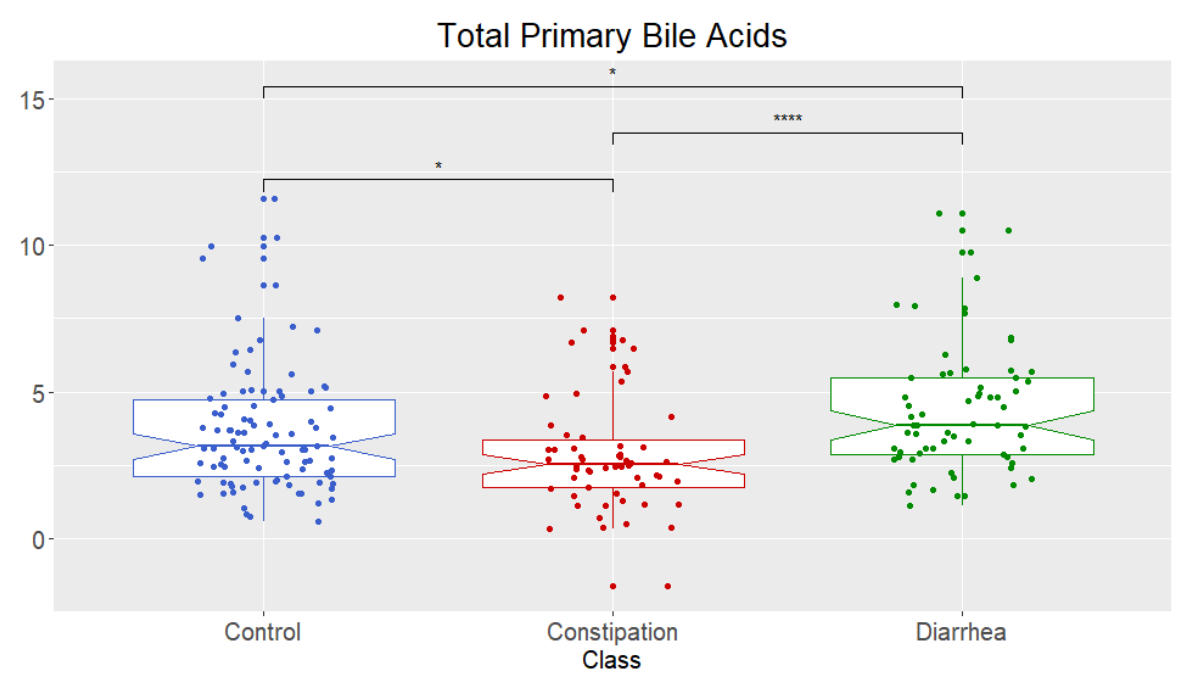
Figure 5. Total concentrations of fecal primary bile acids (sum of chenodeoxycholic acid (CDCA) and cholic acid (CA)) for healthy control and combined groups. Data presented as logged values of µg/mg of dried weight. Healthy control, constipation (FC + IBS-C) phenotype, diarrhea (FD + IBS-D) phenotype. Boxplots show median (center line), 25th and 75th percentile (top and bottom of boxes, respectively), with whiskers representing 1.5 times the inter-quartile range, and boundaries of notches show 95% confidential interval (CI). Statistical significance denoted as p < 0.05 (*), p < 0.001 (****). Constipation group is defined as individuals with both FC and IBS-C. Diarrhea group is defined as individuals with both FD and IBS-D.